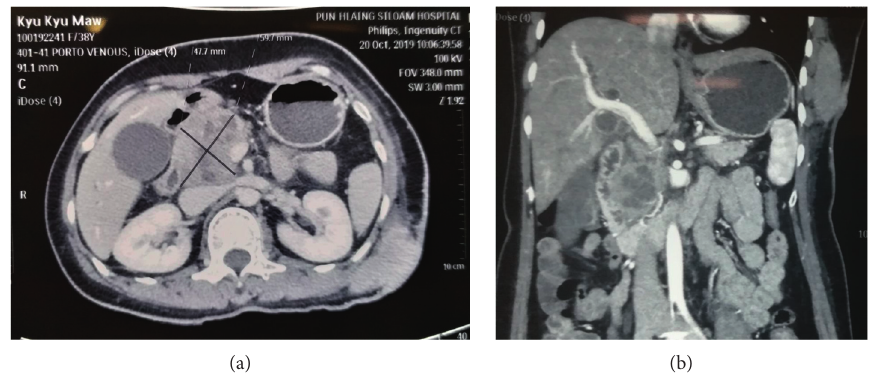
Figure 2: (a), (b) CT revealed malignant cystic pancreatic tumor occupying head and body with invasion to lower end of CBD and periampullary region causing biliary obstruction.